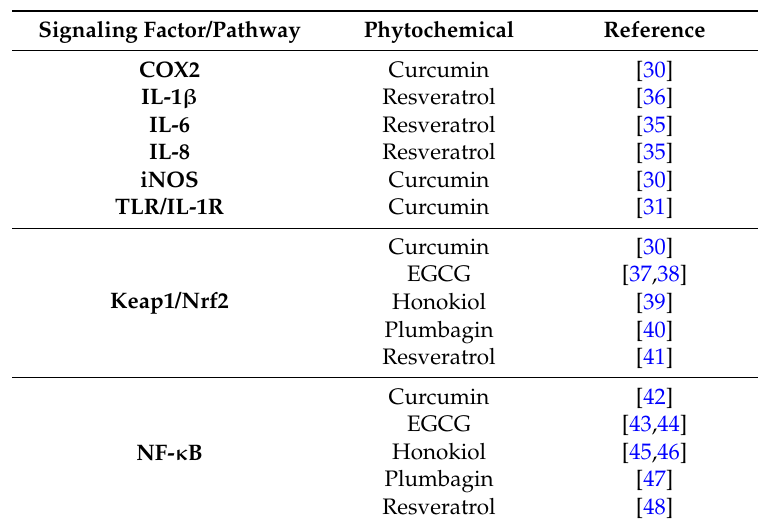
Table 1. Inflammation-influencing signaling factors/pathways modulated by